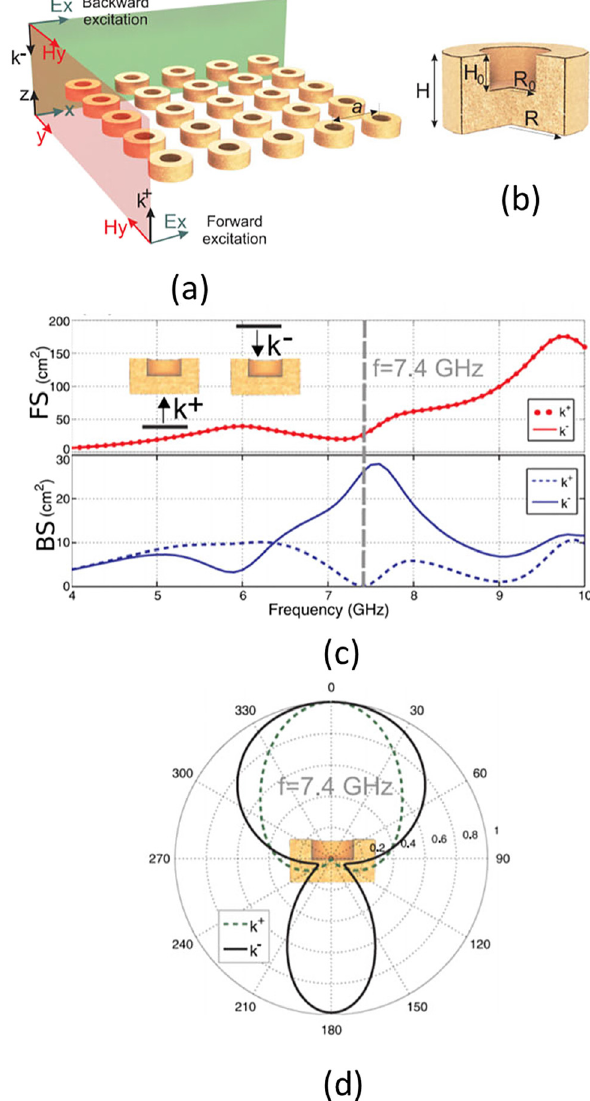
Figure 30: (Reprintedwith permission from Ref. [76]). (a) Schematic of a bianisotropic high-index dielectric metasurface. (b) A cutaway drawing of a single bianisotropic particle. (c) Simulated forward scattering (FS) and backward scattering (BS) of a bianisotropic particle. (d) Numerically simulated radiation patterns of a bianiso- tropic particle at the frequency of 7.4